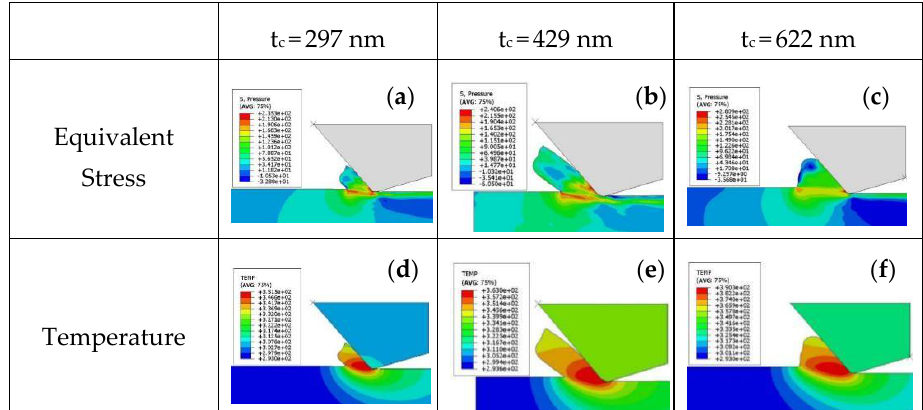
Figure 9. Stress distribution and temperature distribution at different unformed chip thicknesses at cutting speed of 10 m/s: ( a ) Equivalent Stress of tc = 297 nm; ( b ) Equivalent Stress of tc = 429 nm; ( c ) Equivalent Stress of tc = 622 nm; ( d ) Temperature of tc = 297 nm; ( e ) Temperature of tc = 429 nm; ( f ) Temperature of tc = 622 nm.